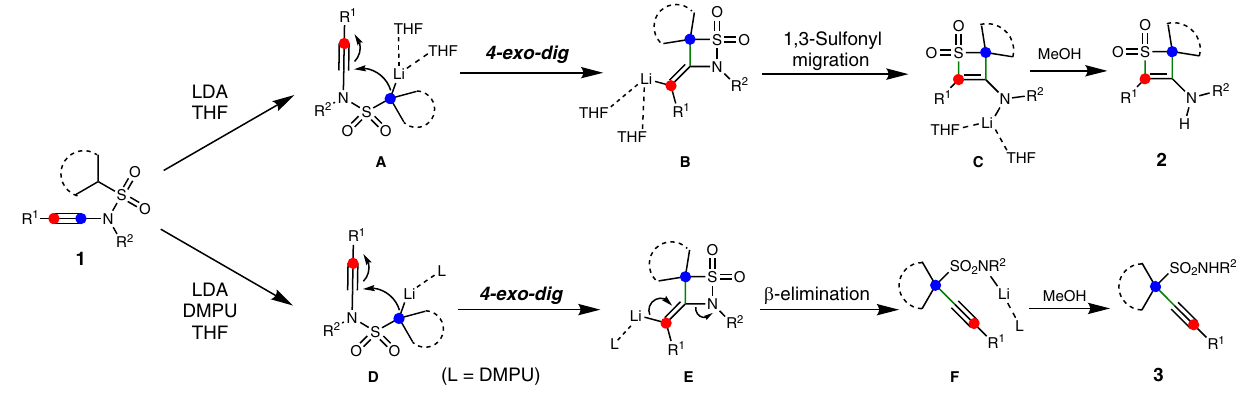
Fig. 9 Plausible mechanism. Possible reaction mechanism of the skeletal reorganization